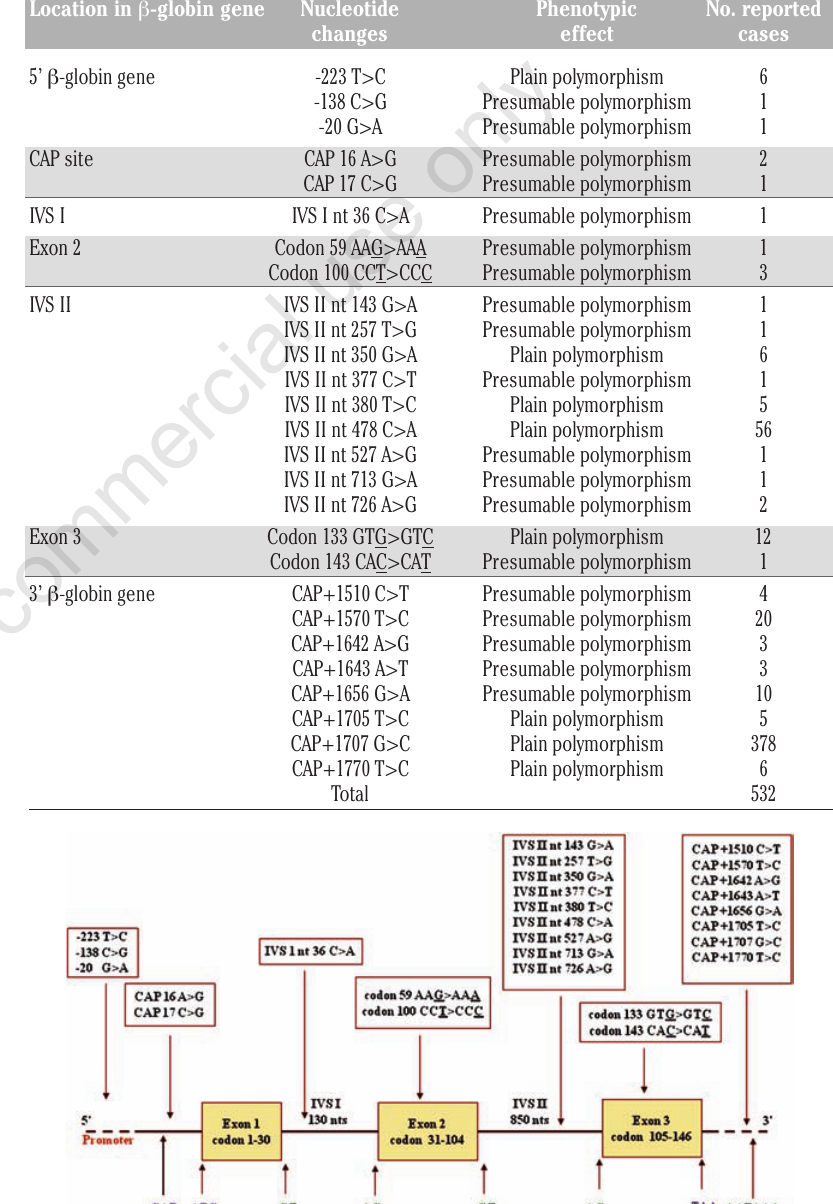
Table 2. Number of reported cases for each nucleotide changes in the β -globin gene iden- tified in our laboratory from 2003 to 2012. Location in β -globin gene